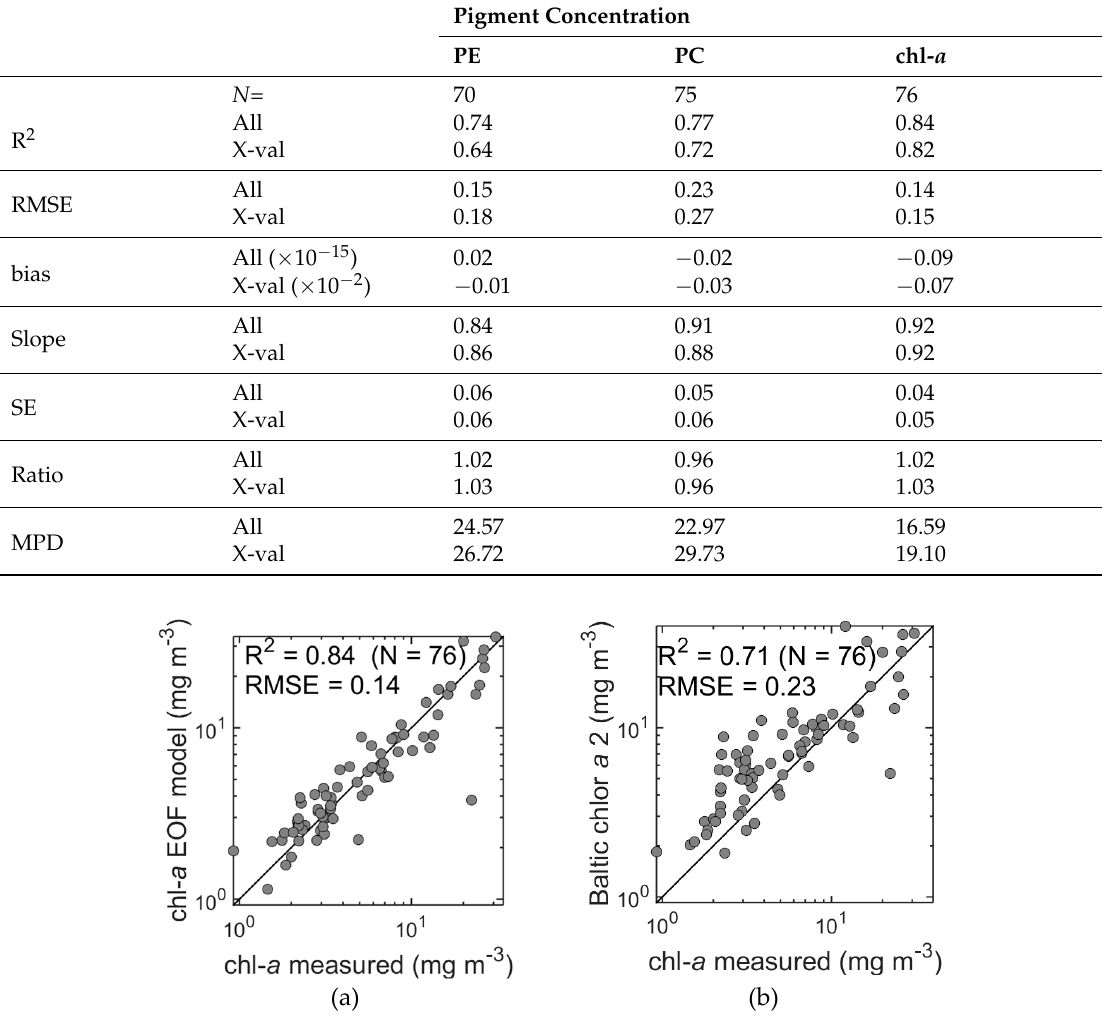
Figure 7. Comparison between chl- a measured in situ and derived from the EOF model ( a ) and the local band ratio algorithm (Baltic chlor a 2) ( b ). Table 5. Statistics of the EOF models for pigment concentration. Units are log 10 (mg·m − 3 ) for pigment concentration. Ratio and MPD are dimensionless.